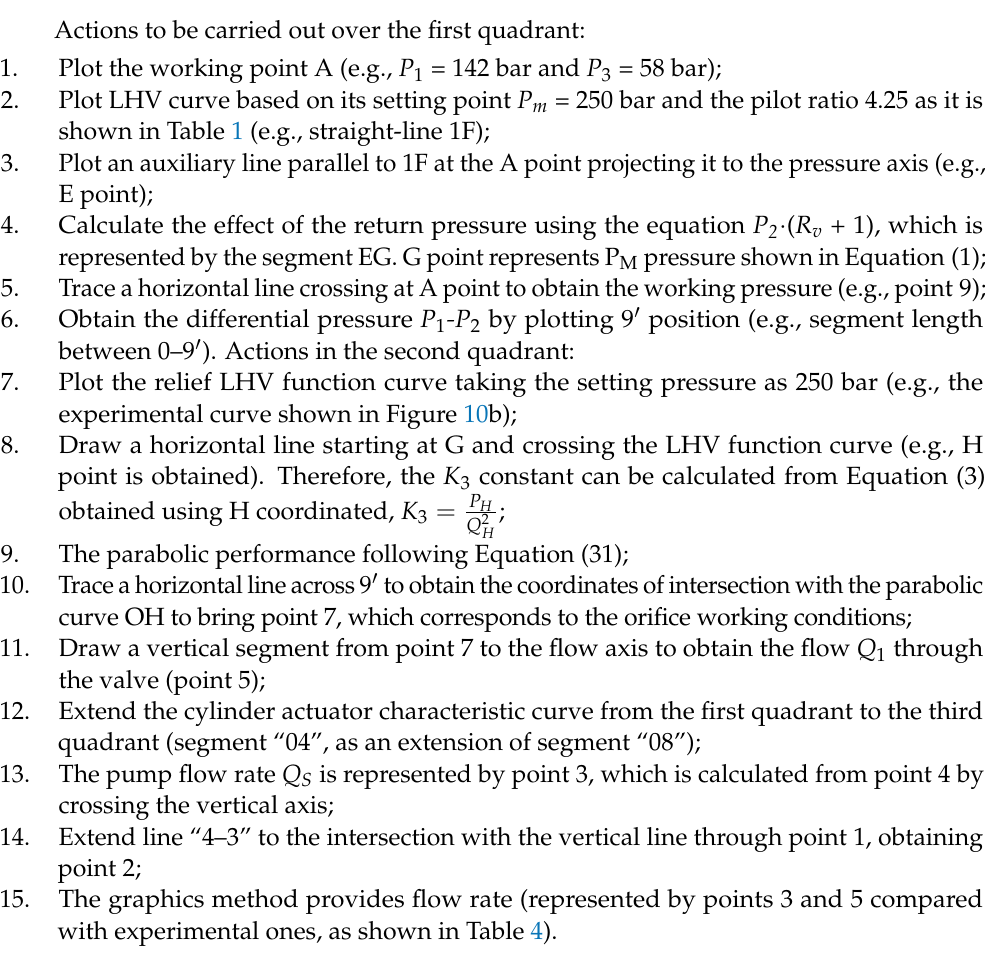
Figure 13. Graphical representation of the power balance for a real case.